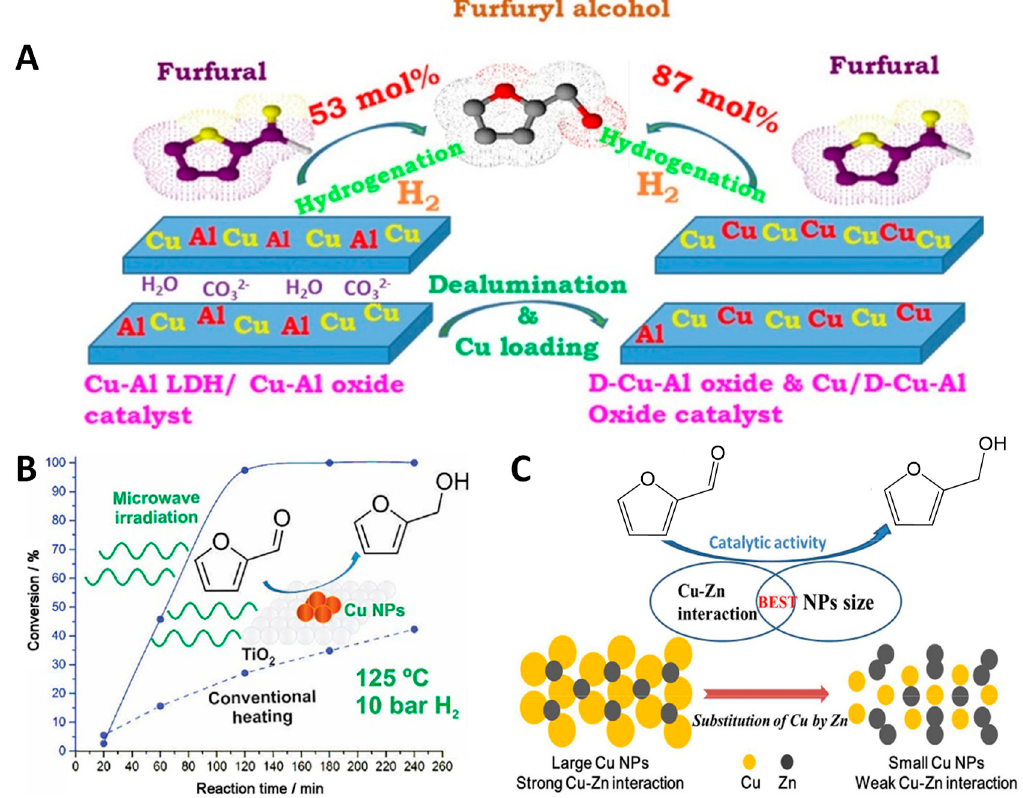
Figure 3. A . Conversion of furfural to furfuryl alcohol (FA) by using Cu-modified dealuminated layered double hydroxides. Reprinted with permission from [121]. Copyright 2016 Elsevier. B . Comparison between furfural hydrogenation over Cu/TiO 2 under conventional heating and microwave irradiation. Reprinted with permission from [59]. Copyright 2016 Wiley-VCH. C